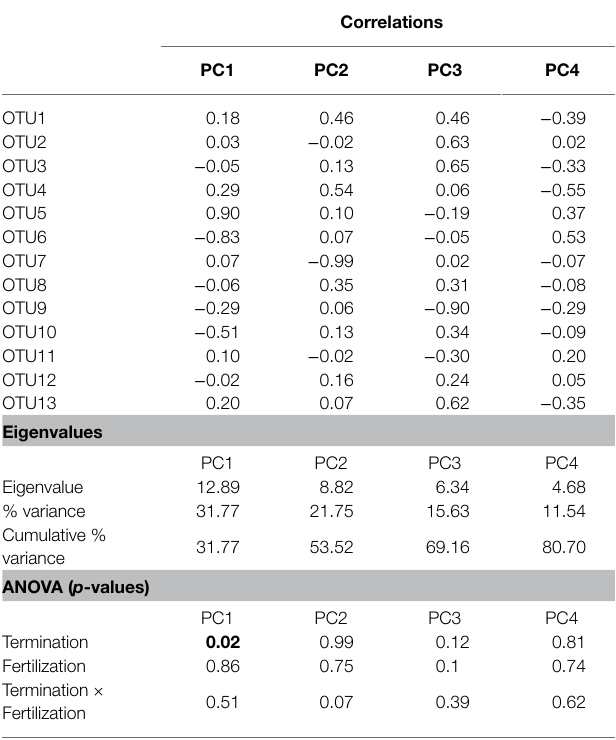
TABLE 4 | Results of principal component analysis (PCA) for amoA AOA centered log-ratio transformed